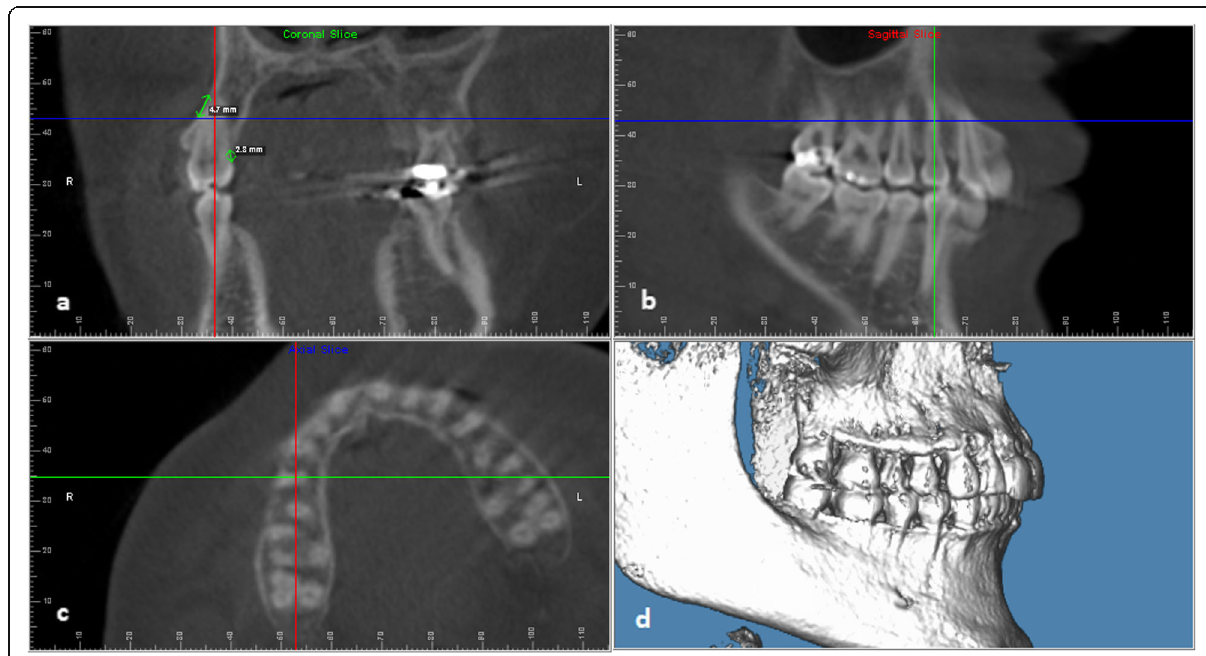
Fig. 1 Bony defect measurement method. Orientation of coronal, axial, and sagittal slices on the multiplanar view and measurement of buccal bony fenestration and lingual dehiscence on UR4 on the coronal cross-section. ( a upper left: coronal view, b upper right: sagittal view, c lower left: axial view, d lower right: volume rendered image)